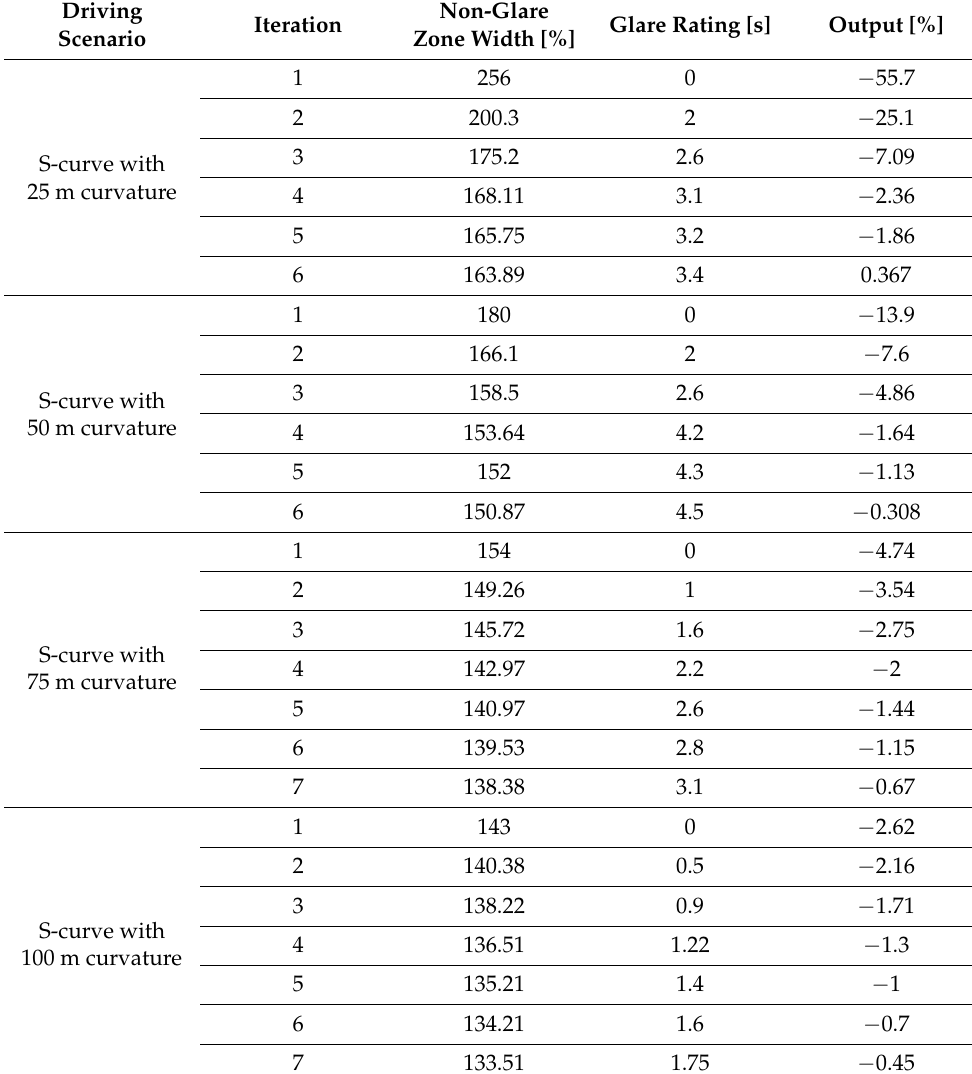
Table 5. Trial 2 iteration of four driving scenarios, using the fuzzy logic controller with Gauss membership